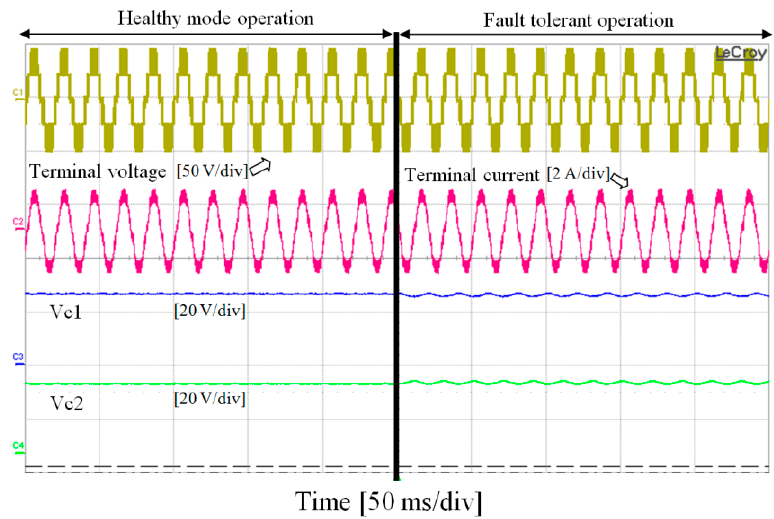
Figure 14. Experimental results of the inverter operation with fault-tolerant control in the case of blowing fuse F4.